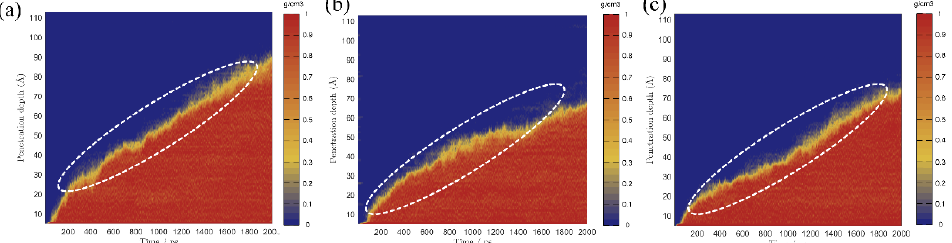
Figure 7. Percolation depth maps of different solutions in C ‐ S ‐ H gel channel with TIA: ( a ) manifests water solution, ( b ) demonstrates NaCl solution, ( c ) represents Na 2 SO 4 solution.